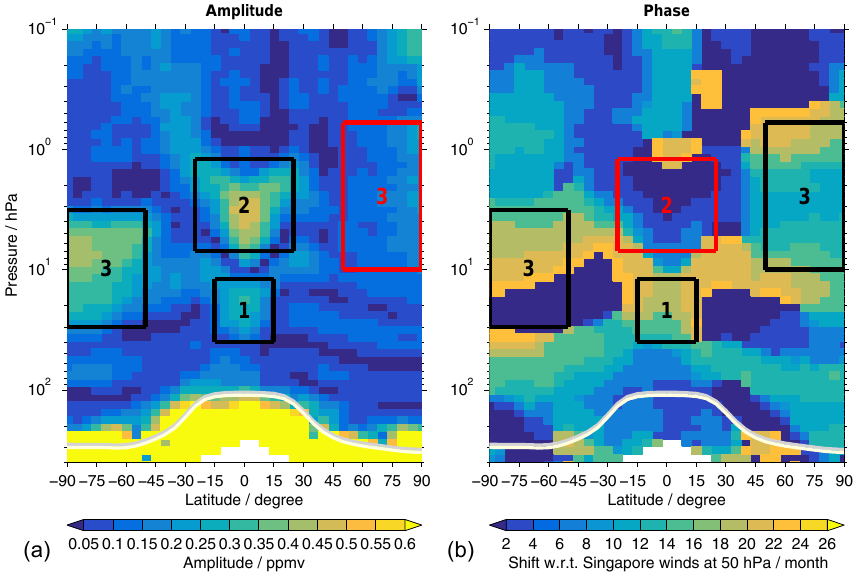
Figure 11. Example of the variability characteristics for the QBO variation based on the MIPAS-IMKIAA V5R NOM data set. The phase is derived as the shift of the QBO regression fit for which the correlation with the Singapore (1 ◦ N, 104 ◦ E) winds at 50hPa maximises.